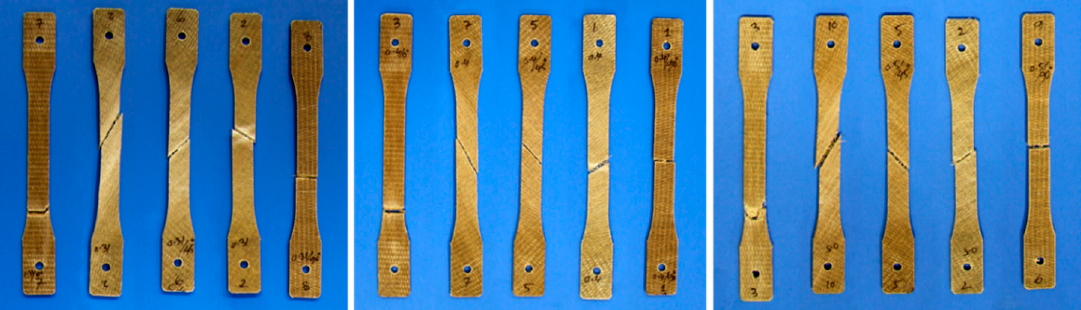
Figure 18. Tensile fracture samples of different fibre volume fractions and orientations. Left ( V f = 0.31), middle ( V f = 0.40), and right ( V f = 0.50), and 0°, 30°, 45°, 60°, and 90° from left to right for each image.